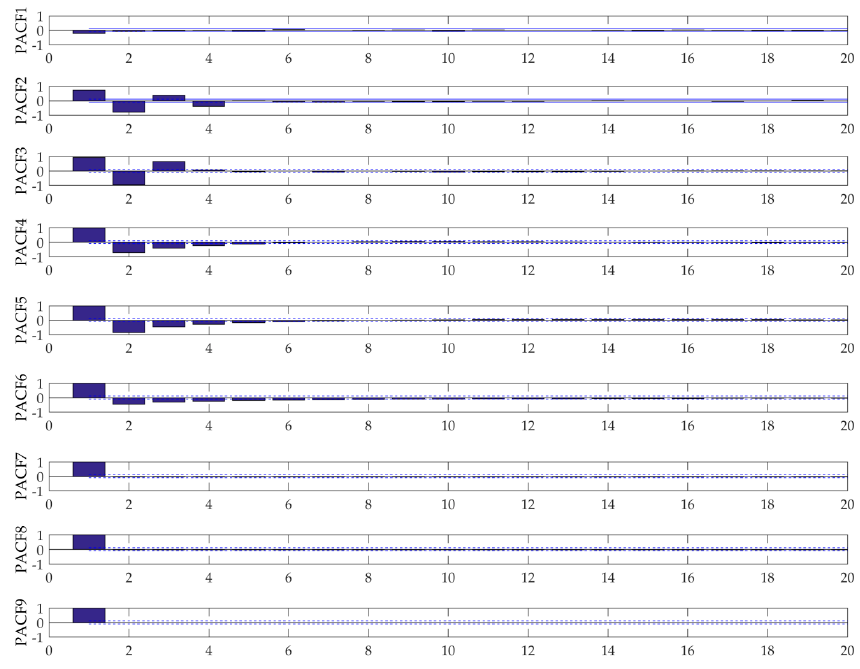
Figure 7. The PACFs of the IMFs and R0.